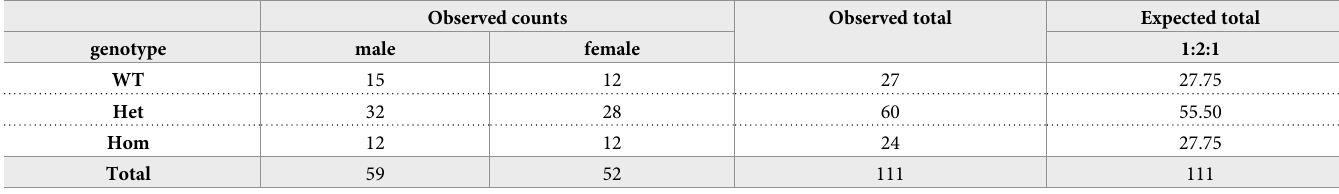
Table 3. A new line of floxed Poldip2 mice produced homozygotes as expected.